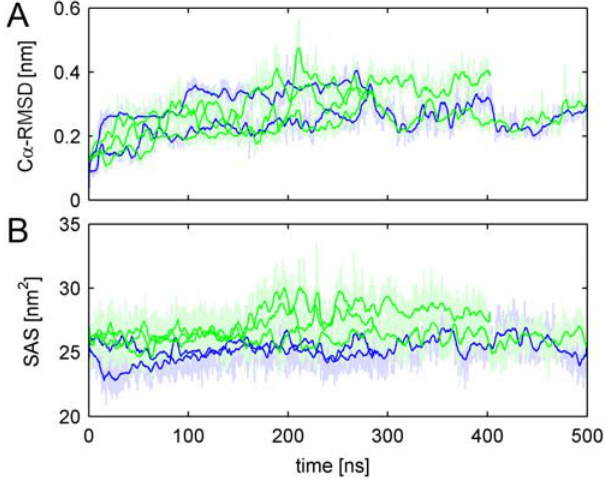
Figure 1. CI2 in native conformation. (A) C a -RMSD. (B) SAS for the two simulations in water (blue) and the 3 simulations in aqueous urea with regular charges (green). The solid bold lines show traces smoothed by a running average over 500 ps; dim lines show raw data.